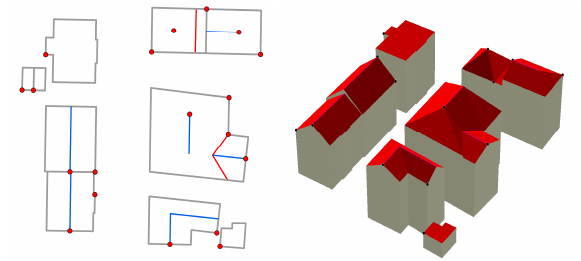
Figure 11. From the building ground plan (left) to the 3D Model (right)